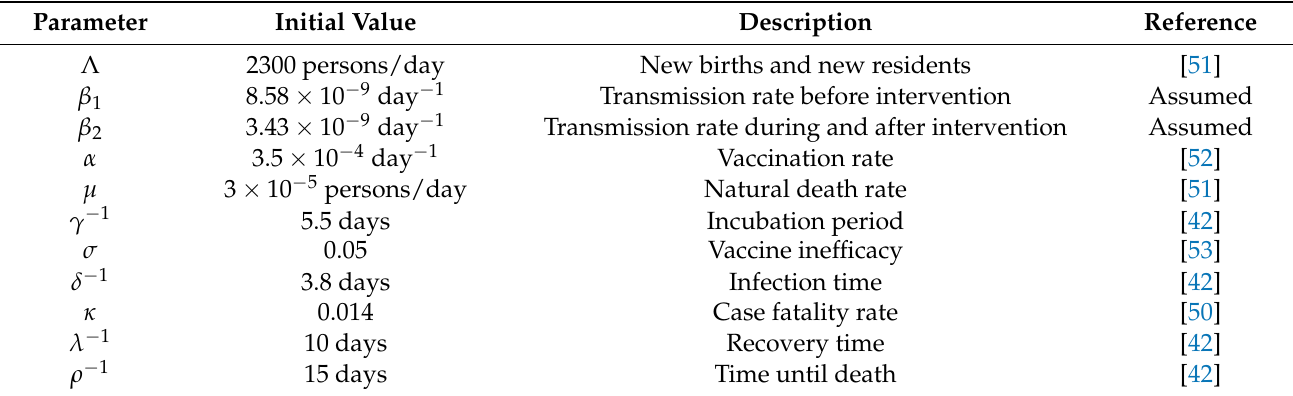
Table 1. Initial model parameters and biological